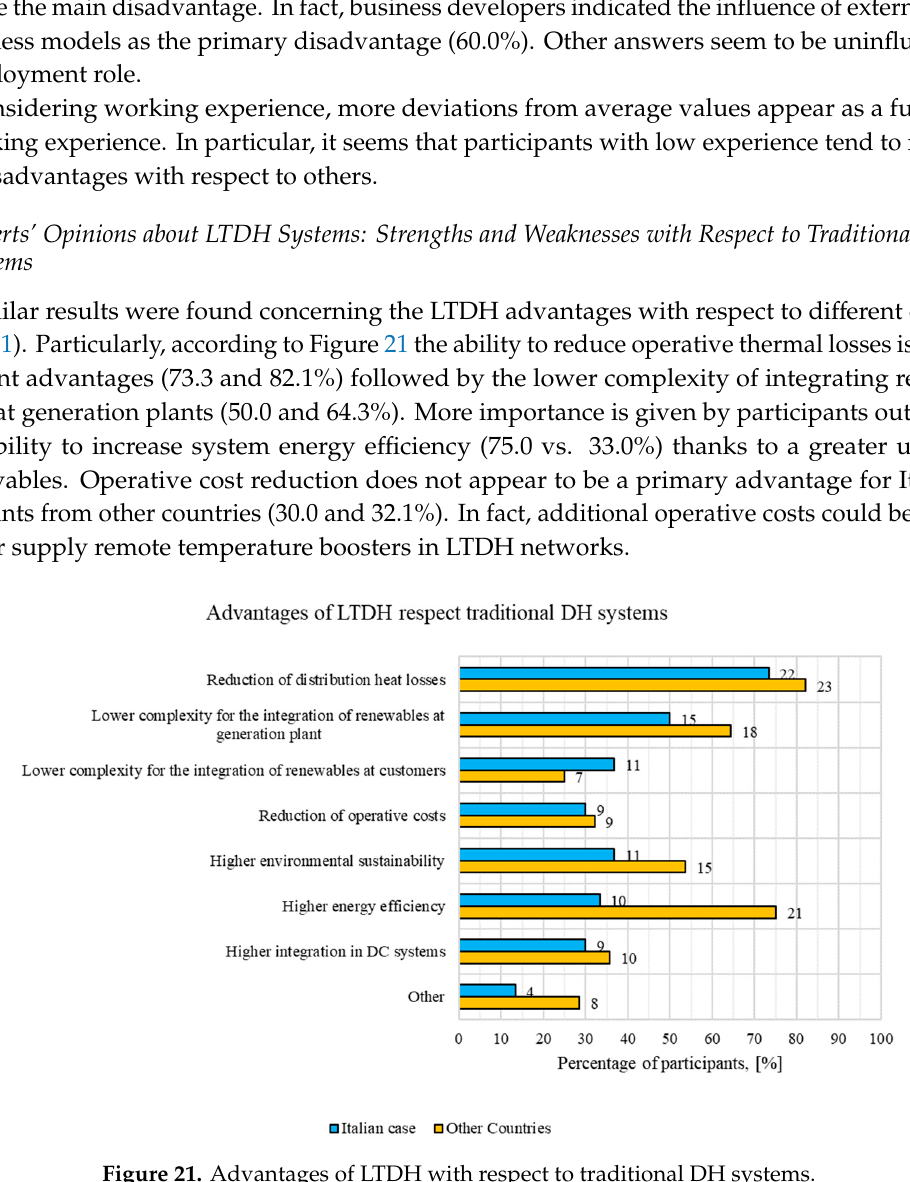
Figure 20. Disadvantages of traditional DH systems with respect to individual heating systems as a function of the experience.